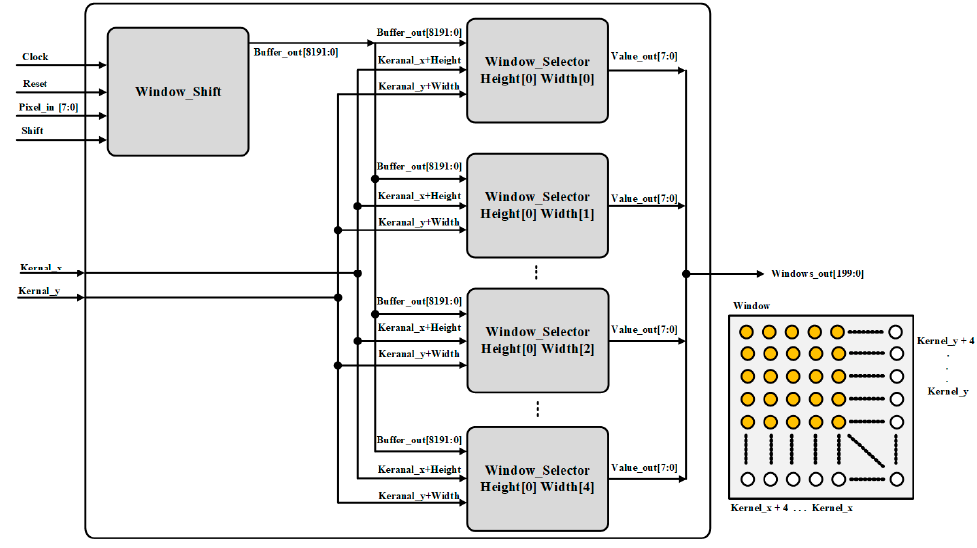
Figure 5. Window wrapper structure.